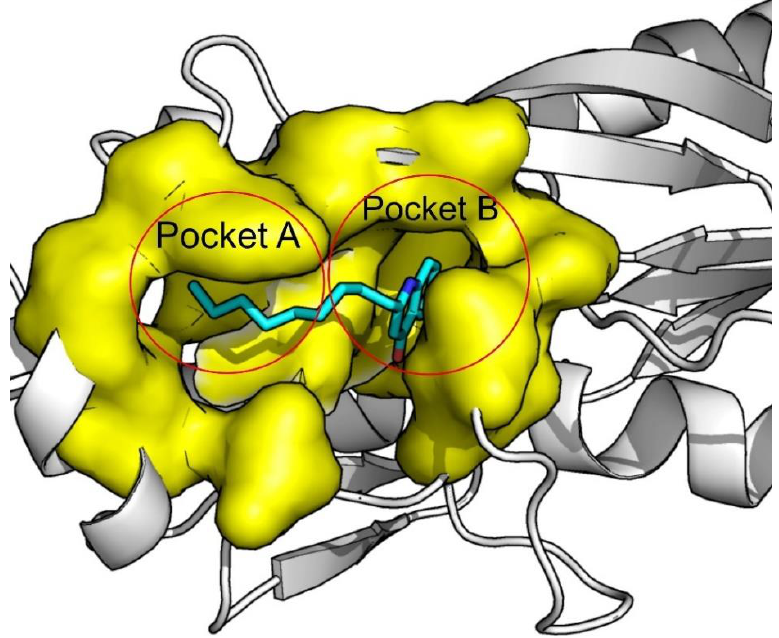
Figure 1. MvfR pocket A and pocket B depiction. Protein bound to its natural inducer NNQ. (PDB:4JVI).